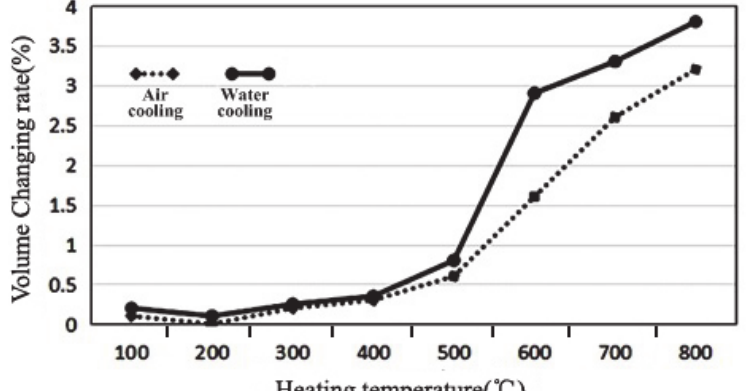
Figure 3: Volume changing rate after heating.